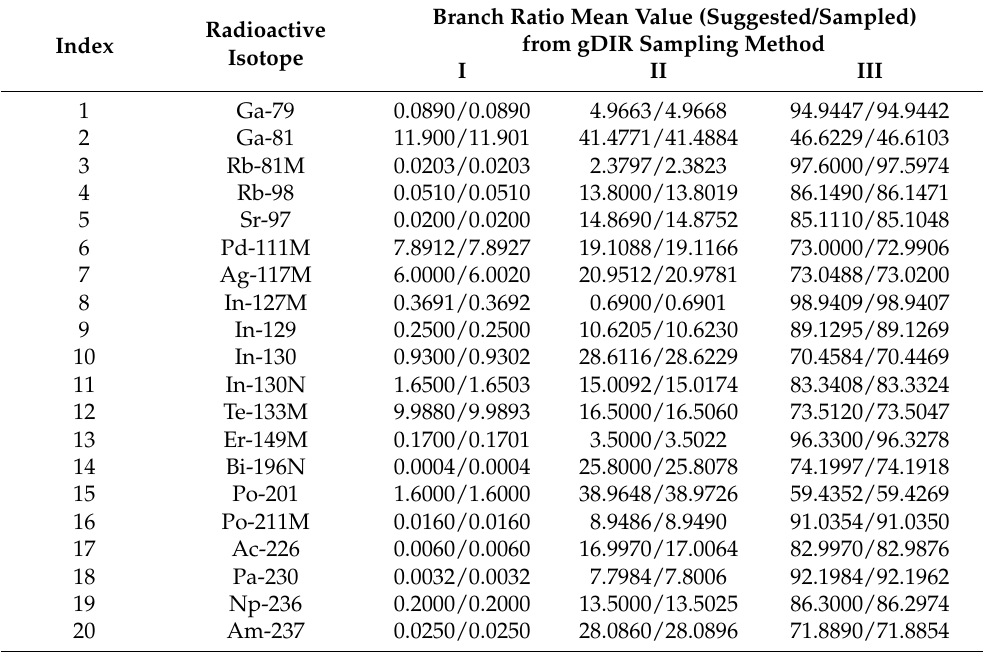
Table A3. gDIR sampling: branch ratio mean value estimation